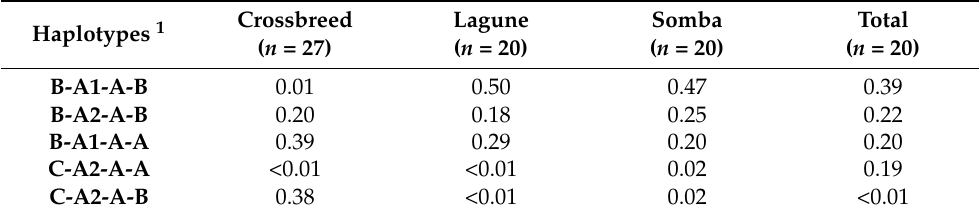
Table 4. Frequencies of the bovine casein haplotypes ( CSN1S1-CSN2-CSN1S2-CSN3 ) in the different Beninese breeds and across all investigated cattle.